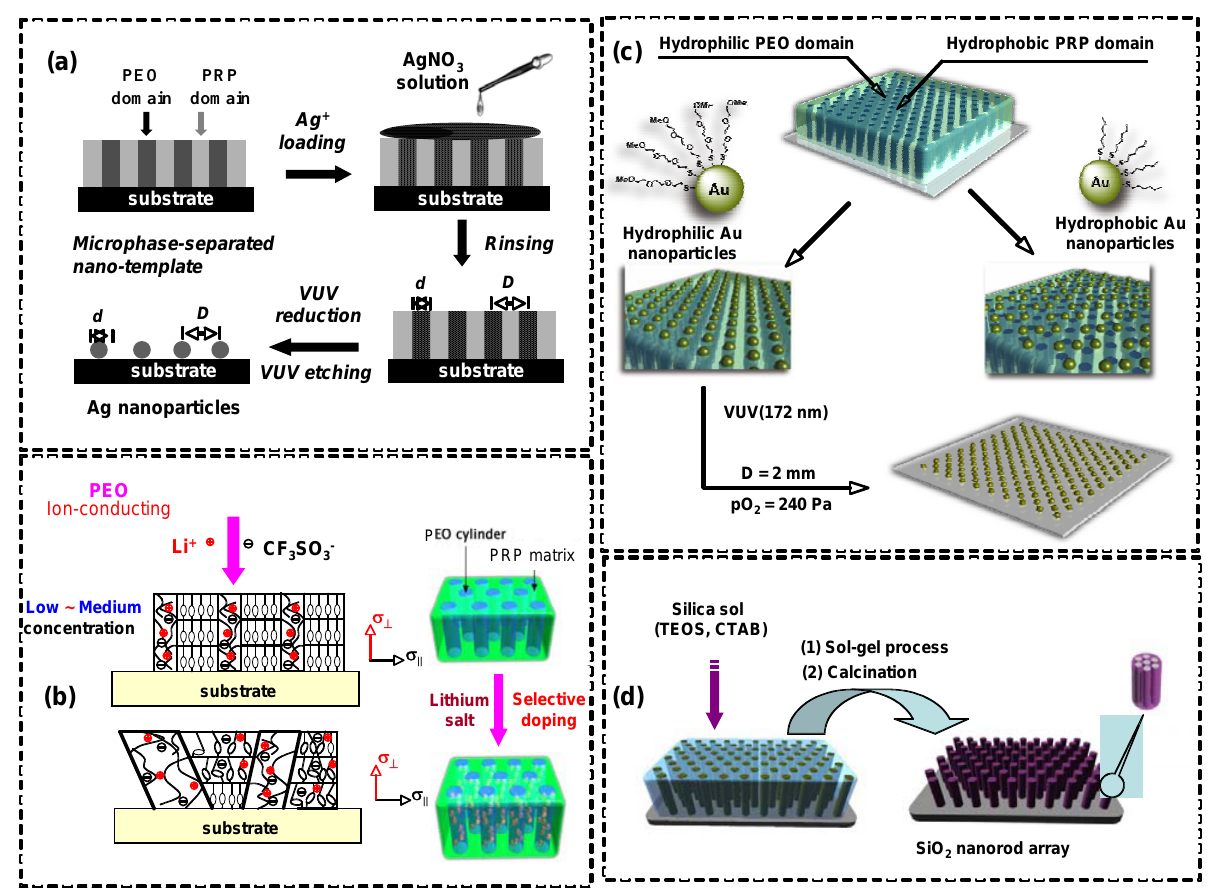
Figure 21. Nanotemplate applications of PRBCs. (a) Fabrication of periodic array of Ag nanoparticles. (b) Anisotropic ionic conduction in nanochannels. (c) Selective absorption of Au nanoparticles. (d) Preparation of SiO nanorod arrays by combination of a sol-gel 2 process with PRBC